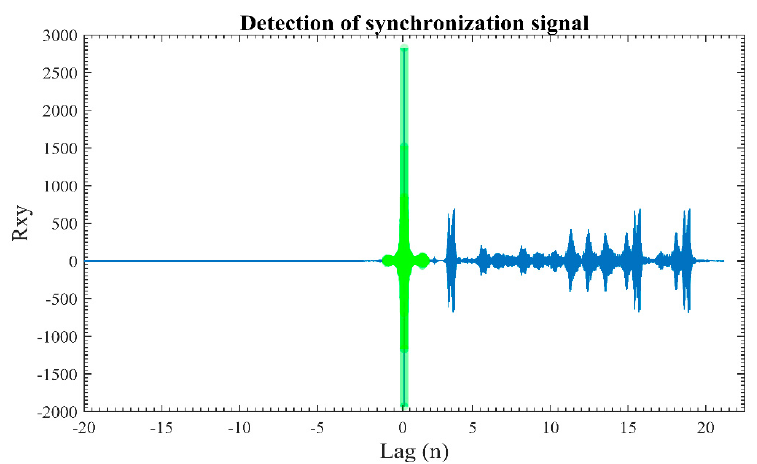
Figure 8. Detection of the synchronization waveform at the receiver.